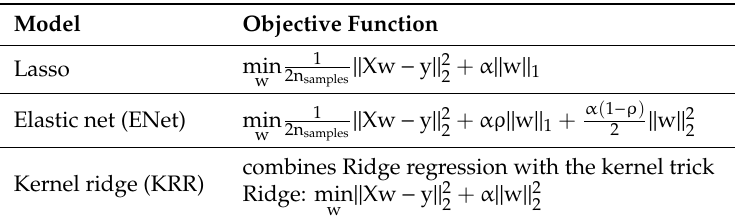
Table 4. Algorithm of linear regression